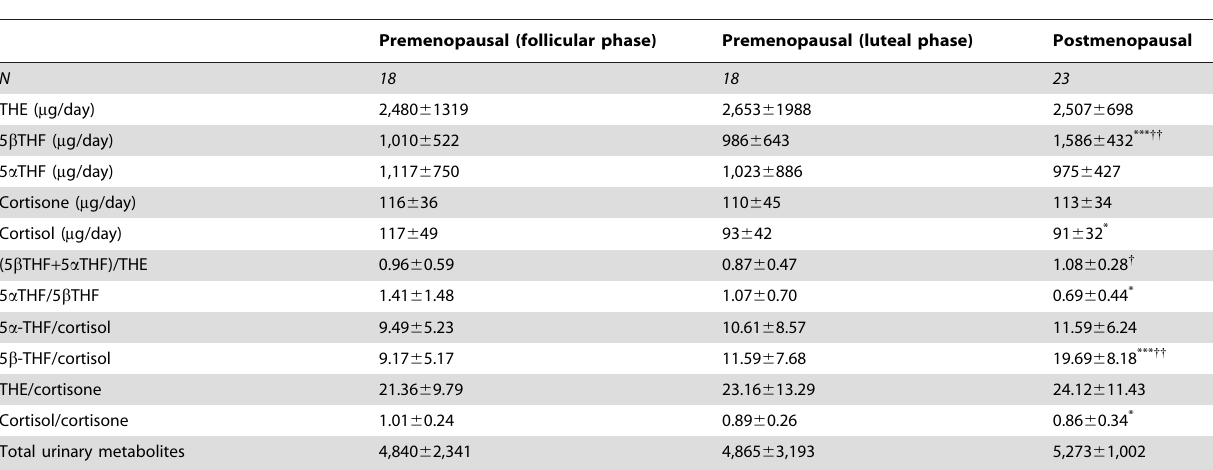
Table 3. Urinary corticosteroid metabolites.